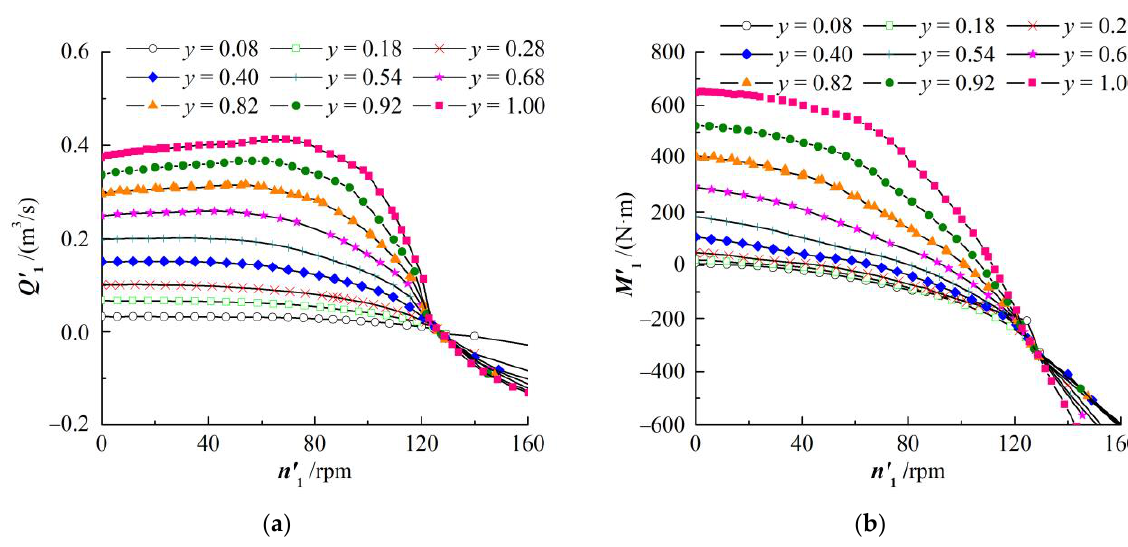
− Q (cid:48) − M (cid:48) curves. ( b ) n (cid:48) curves. 1 1 1 1